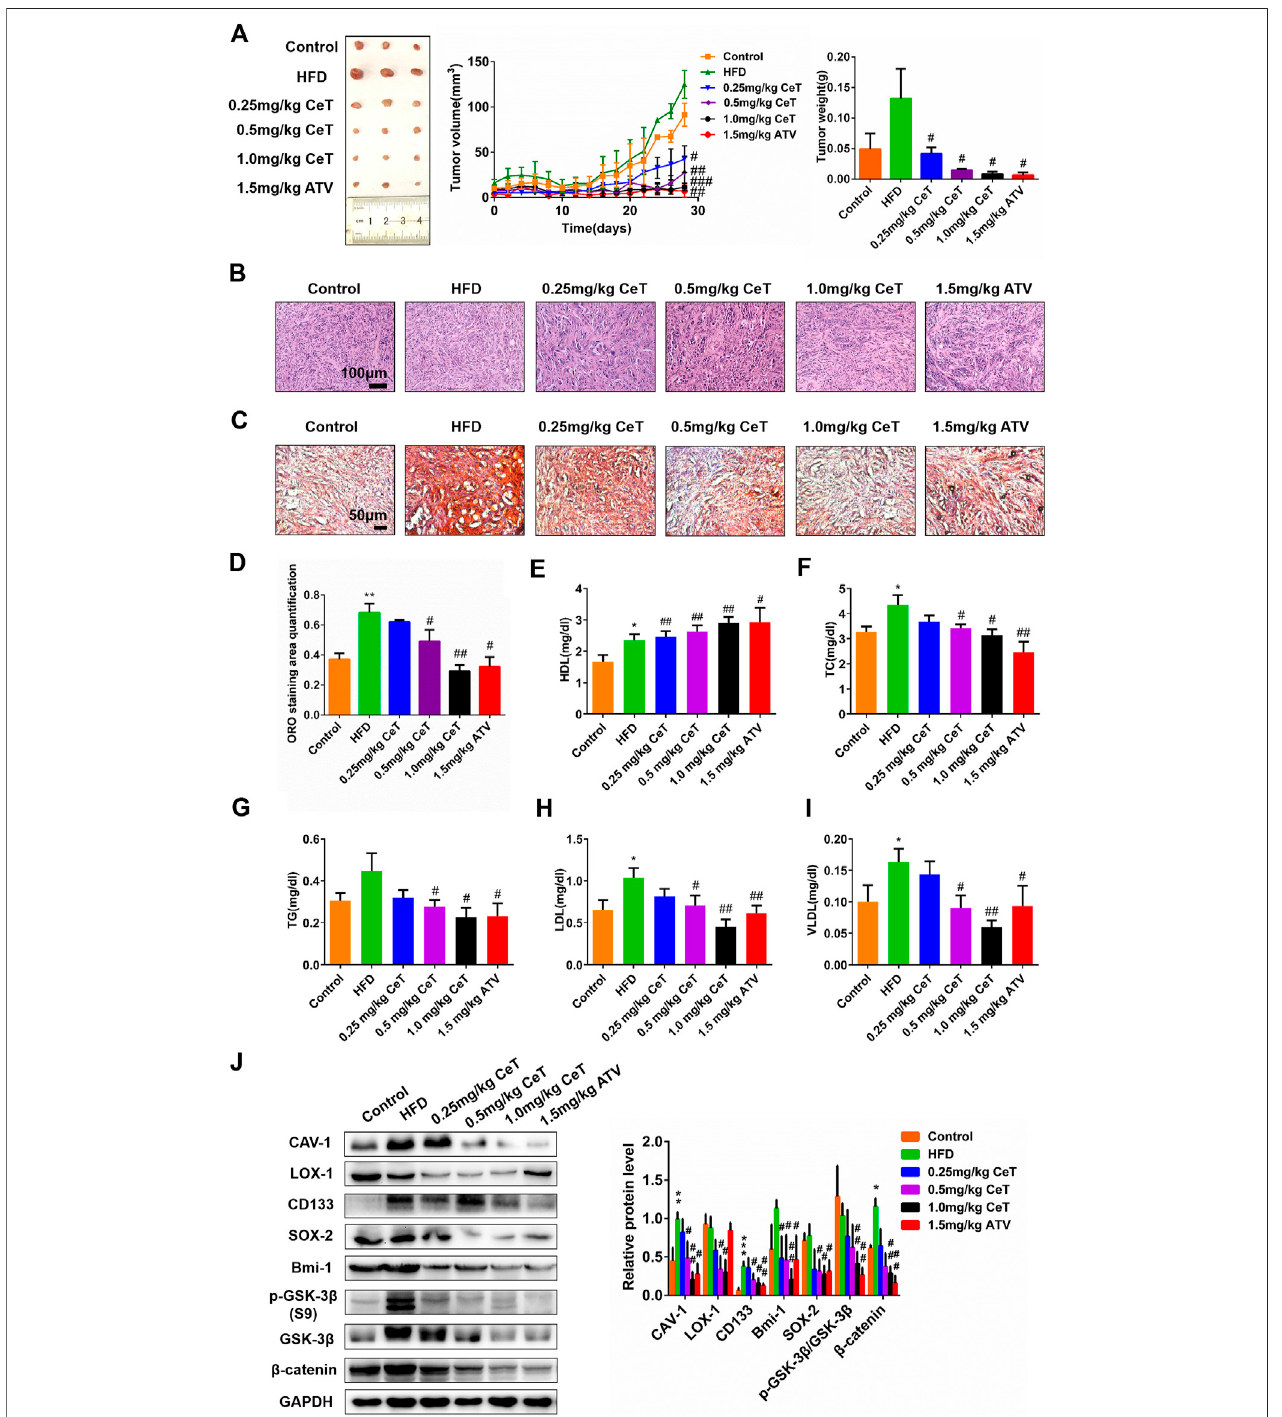
FIGURE 2 | Celastrol inhibited the growth of xenografts tumors of 786-O cells in vivo (A) Nude mice were injected subcutaneously with 1 × 10 7 786-O cells. Mice were then treated with CeT (0.25, 0.5, 1.0 mg/kg), ATV (1.5 mg/kg) for 4 weeks. The tumor volume at the indicated time-points were calculated every two days after treatment,andthetumorweightwascalculatedatendoftheexperiments (B) RepresentativeimagesofH&Estaining.Scalebar:100 μ m (C,D) Lipiddepositionoftumor tissues was measured by Oil red O staining. Scale bar: 20 μ m. (E-I) The biochemical analysis was used to evaluate plasma levels of HDL, TC, TG, LDL, and VLDL. (J) TheproteinlevelsofCAV-1,LOX-1,CD133,Bmi-1,SOX-2,p-GSK-3 β (S9),GSK-3 β ,and β -catenininxenograftstumorswereanalyzedbywesternblotting.Thedata were shown as the mean ± SD of three replicates. * p < 0.05, ** p < 0.01 vs. the control group; # p < 0.05, ## p < 0.01, ### p < 0.001 vs. the HFD group.